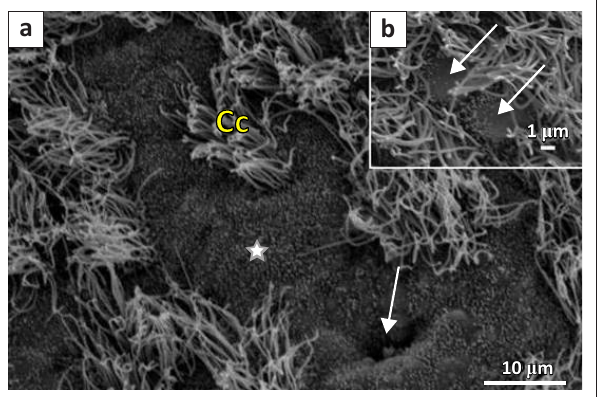
(a) Scanning electron photomicrograph of the mucosal surface of the magnum in a bird treated with carbendazim at a dose of 400 mg/kg bodyweight; Asterisk, Area of deciliation; Cc, ciliated cells with intact cilia; Arrow, glandular opening. (b) Degenerating non-ciliated cells lined by a few microvilli (arrows).